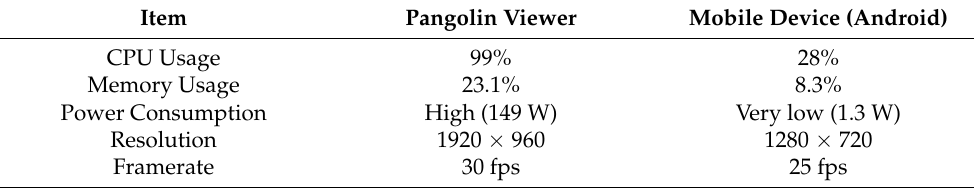
Table 2. Comparison of Pangolin Viewer and Unity Engine’s Mobile Viewer.